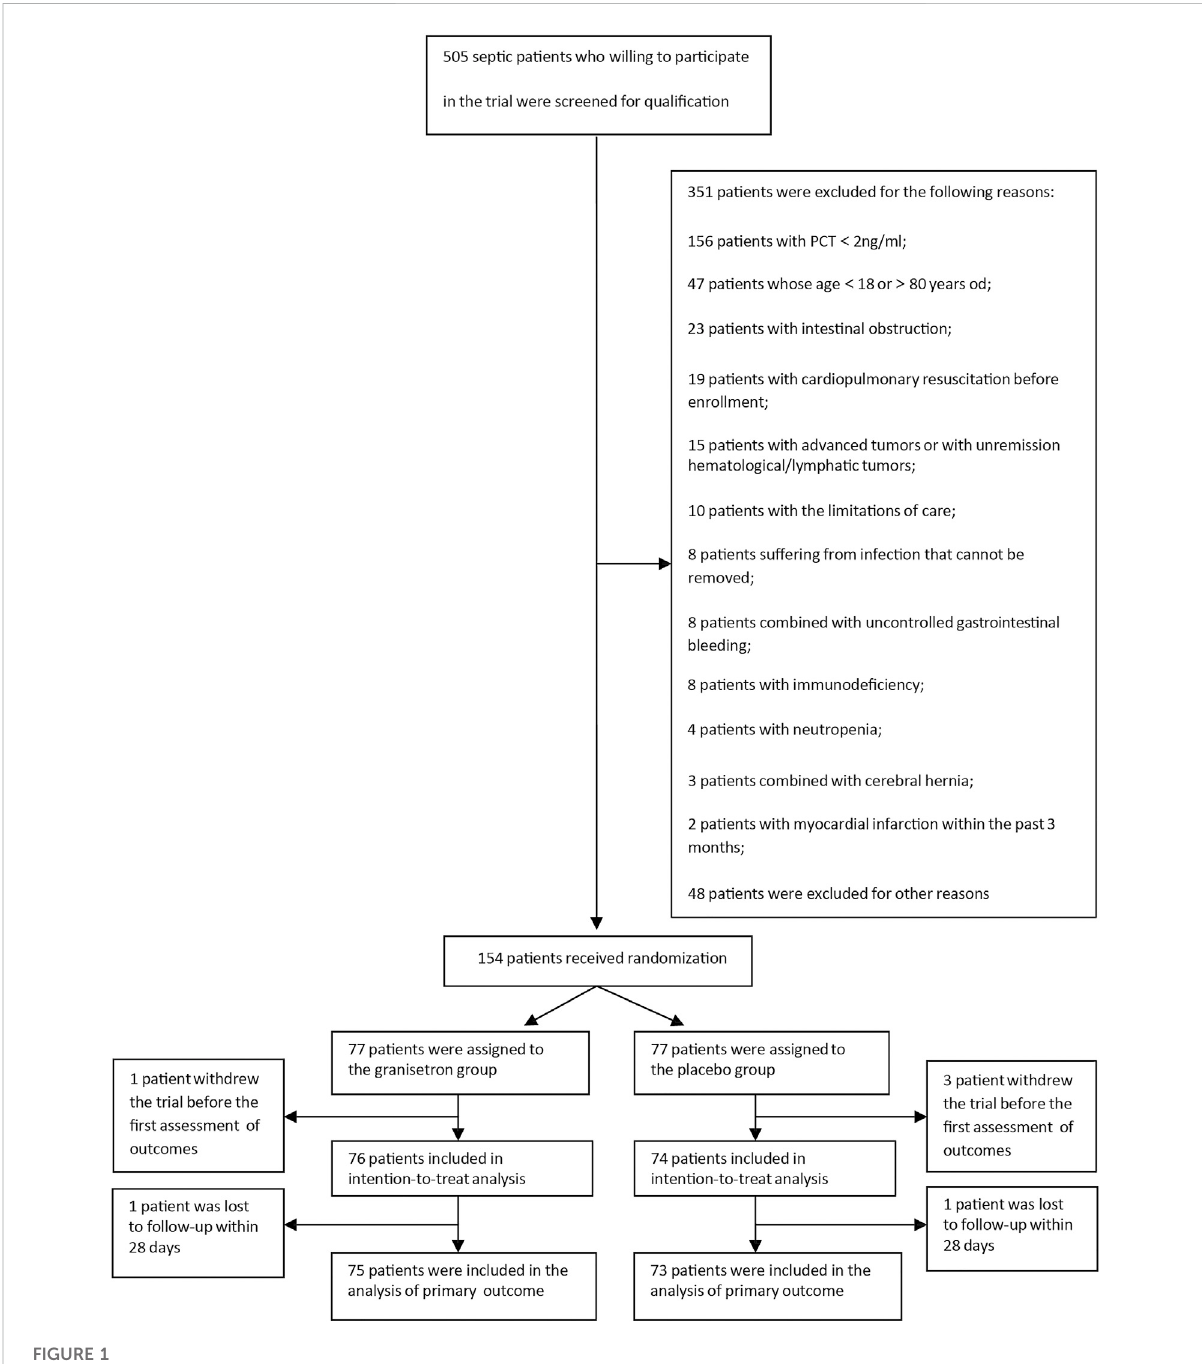
FIGURE 1 Flow chart of patient